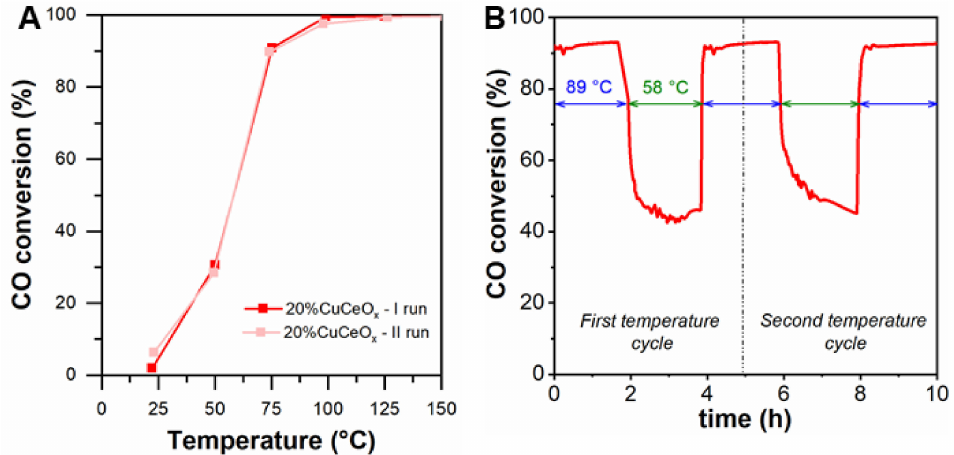
Figure 11. ( A ) Thermal stability study of the 20%CuCeO x for two consecutive CO oxidation tests and ( B ) CO conversion (%) over the time during the long-term stability test for the 20%CuCeO x